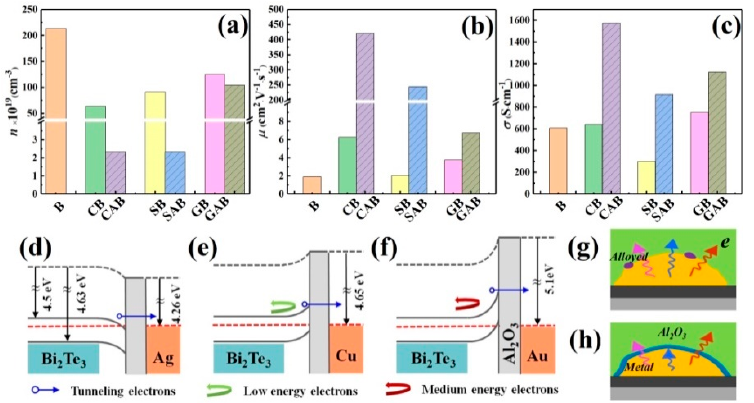
Figure 3. Electrical properties of Bi 2 Te 3 -based films at 300 K. ( a ) Carrier concentration ( n ). ( b ) Carrier